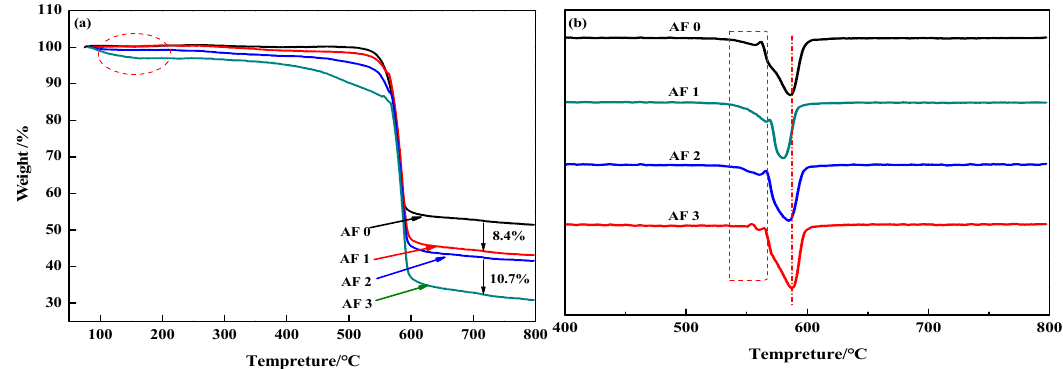
Figure 10. ( a ) TG and ( b ) DTG curves of aramid fiber before and after modification.